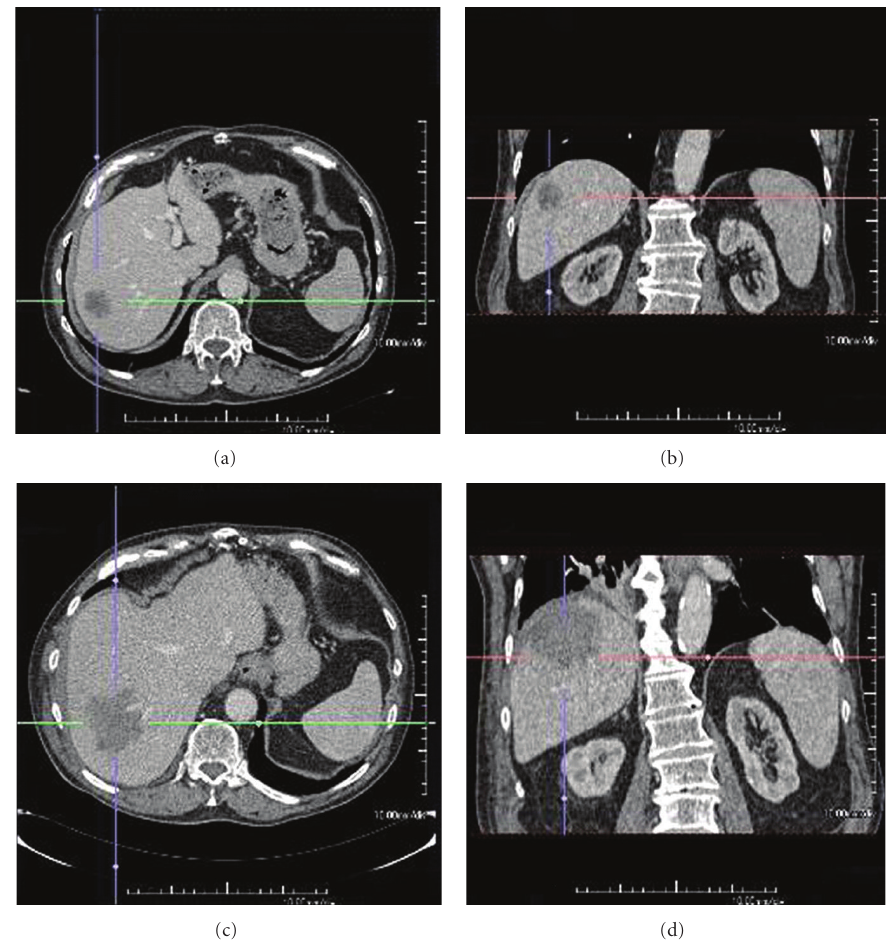
Figure 3: Similarity of Positioning Score-di ff erent (SiPS-di ff ). Example of nonidentical (discordant) pre-RFA CT-images and post-RFA CT-images, classified as Similarity of Positioning Score-di ff erent (SiPS-di ff ). The pre-RFA CT-scan ((a) axial, (b) coronal) and post-RFA CT-scan ((c) axial, (d) coronal) are not